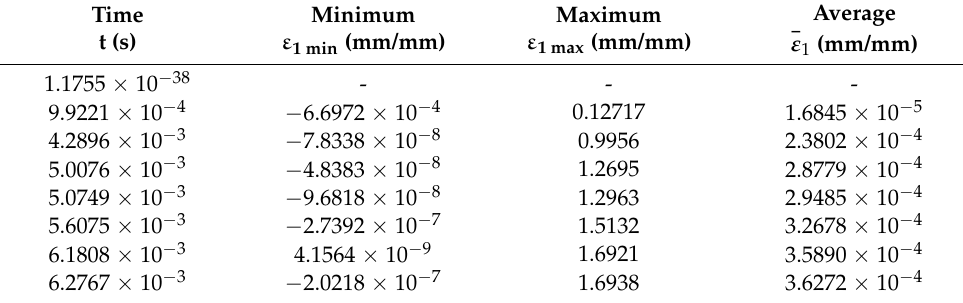
Table 6. Maximum principal elastic strain.